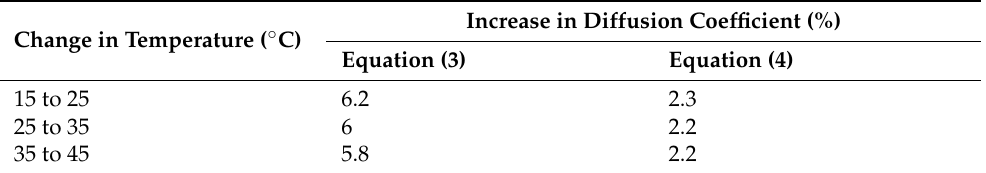
Table 2. Effect of temperature on the diffusion coefficient.